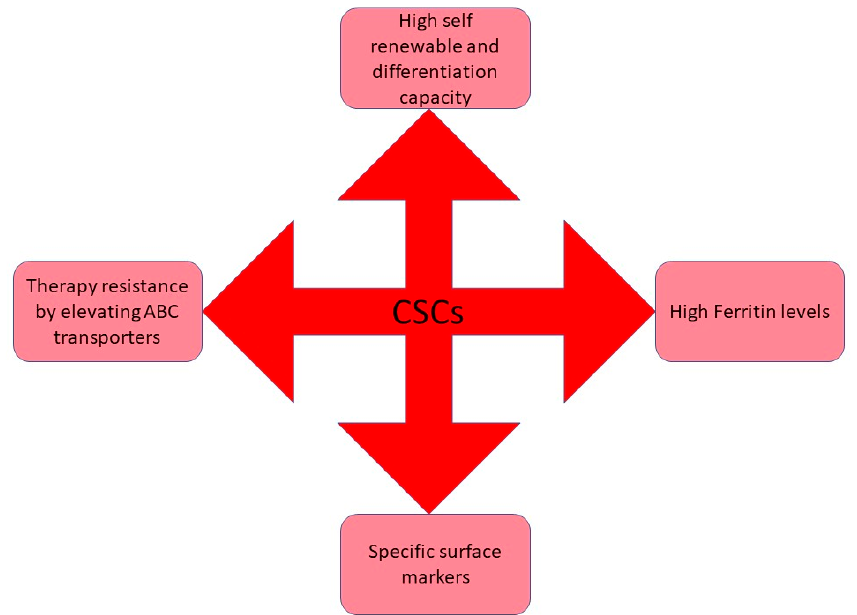
Figure 2. Schematic representation of various characteristic features of cancer stem cells. To survive in the harsh tumor microenvironment CSCs acquire several modifications such as therapy-resistance to abscond the adverse effects of the cancer regimens, self-renewable potential to undergo continuous proliferation, and so on.